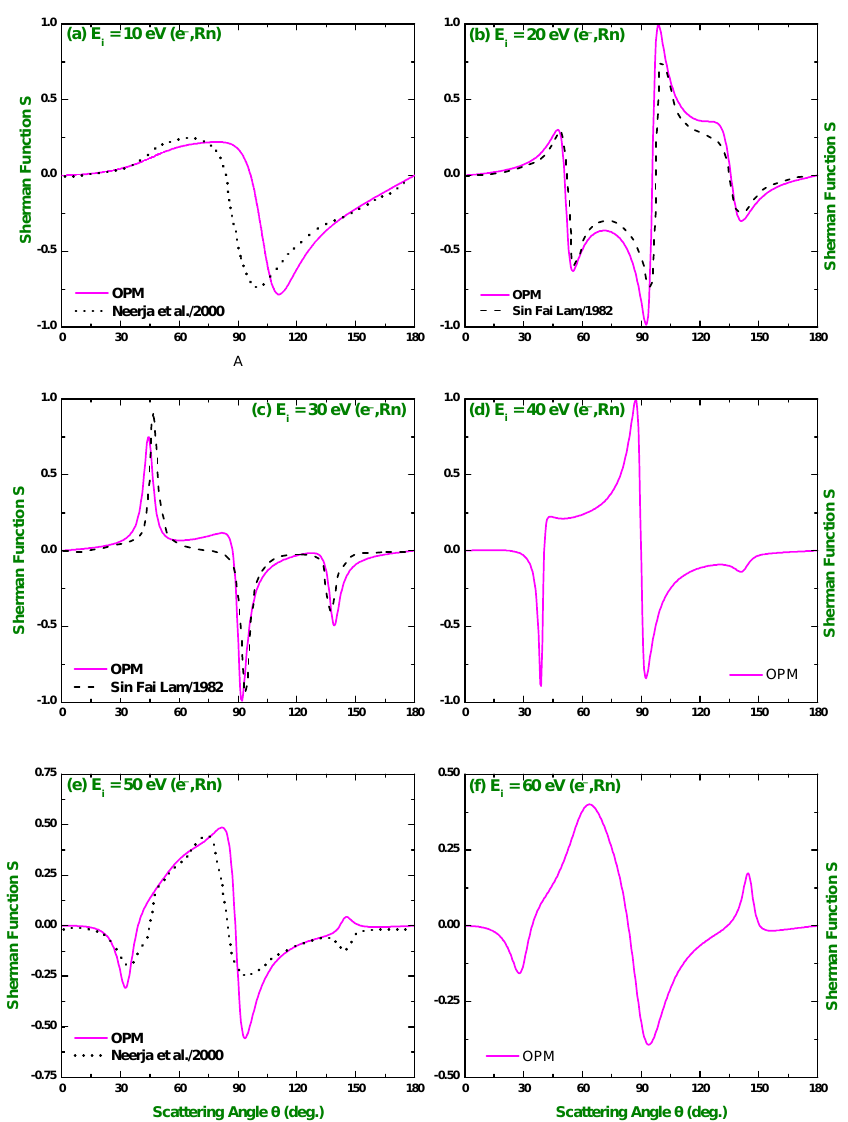
Figure 10. Angle dependent Sherman function S for elastic scattering of 10, 20, 30, 40, 50 and 60 eV electrons from neutral radon atoms: — curves, present calculations (MCP); · · · · · · curves, ref. [19] and − − − curves, Ref.